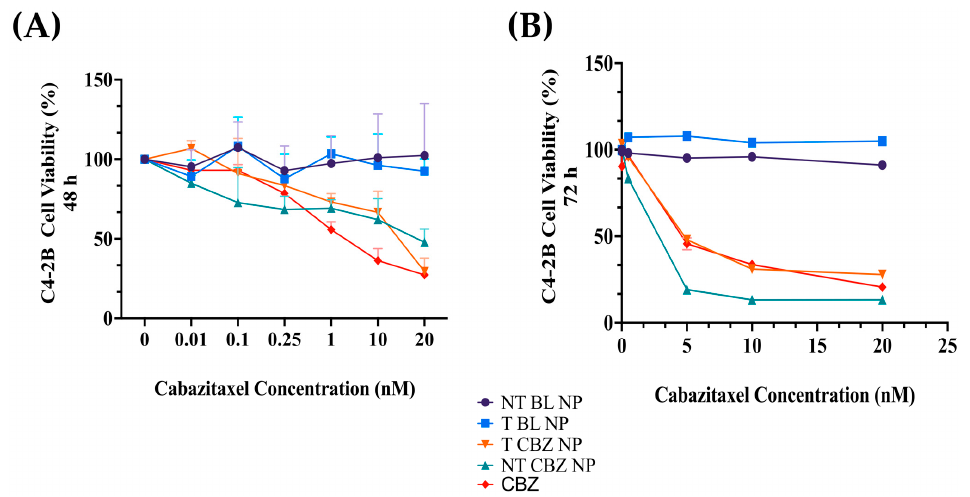
Figure 3 . ( A ) Cell viability in C4-2B cell line. The 48 h IC 50 values in C4-2B cells are as follows: CBZ, 2.8 nM; NT CBZ NP, 24.5 nM; T CBZ NP, 10.52 nM. ( B ) The 72 h IC 50 values are: CBZ, 4.96; NT CBZ NP, 1.81 nM; T CBZ NP, 5.21 nM (95% confidence intervals (CI)); n = 3. Graphs created with GraphPad Prism 9.4.1. (n =